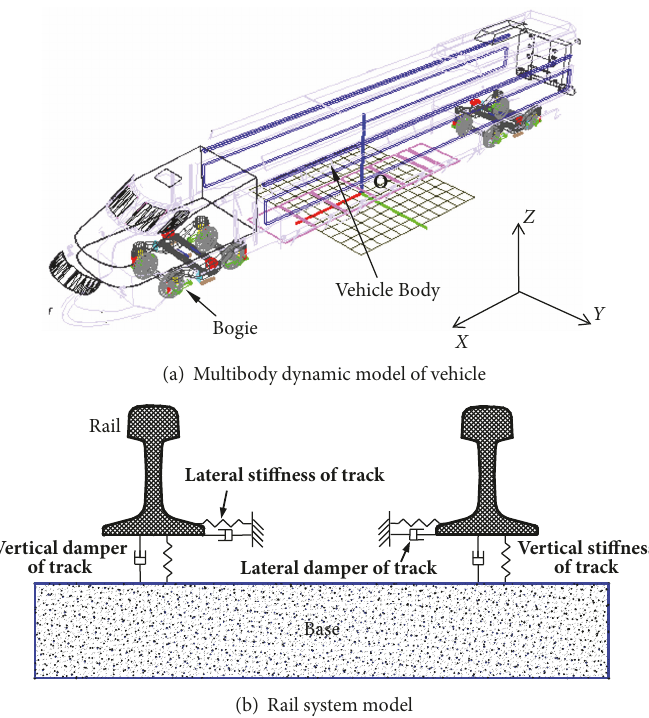
Figure 1: Multibody dynamic model of vehicle-track